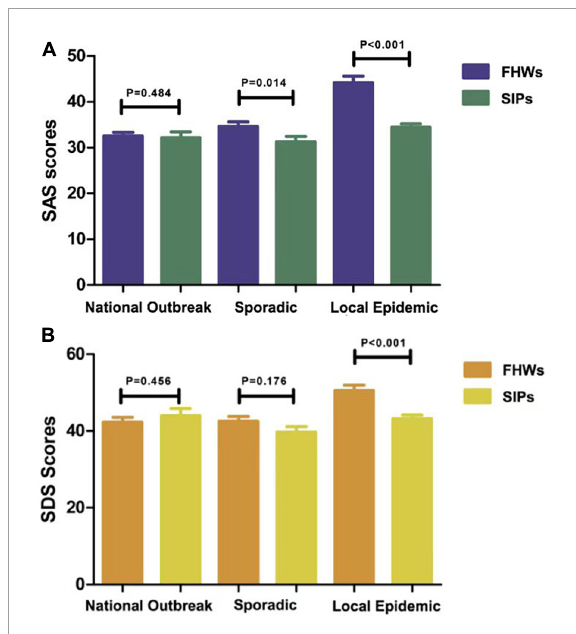
FIGURE5 Comparison of SAS (A) and SDS (B) scores of frontline health care workers (FHWs) and suspected infected patients (SIPs) during different